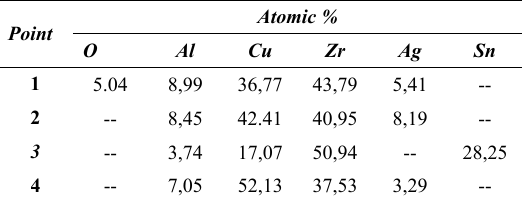
Figure 5. Selected point for EDS analysis and results. In a: Cu Table 2. EDS results of atomic percentages, for points 1-4, indicated in figure 5.